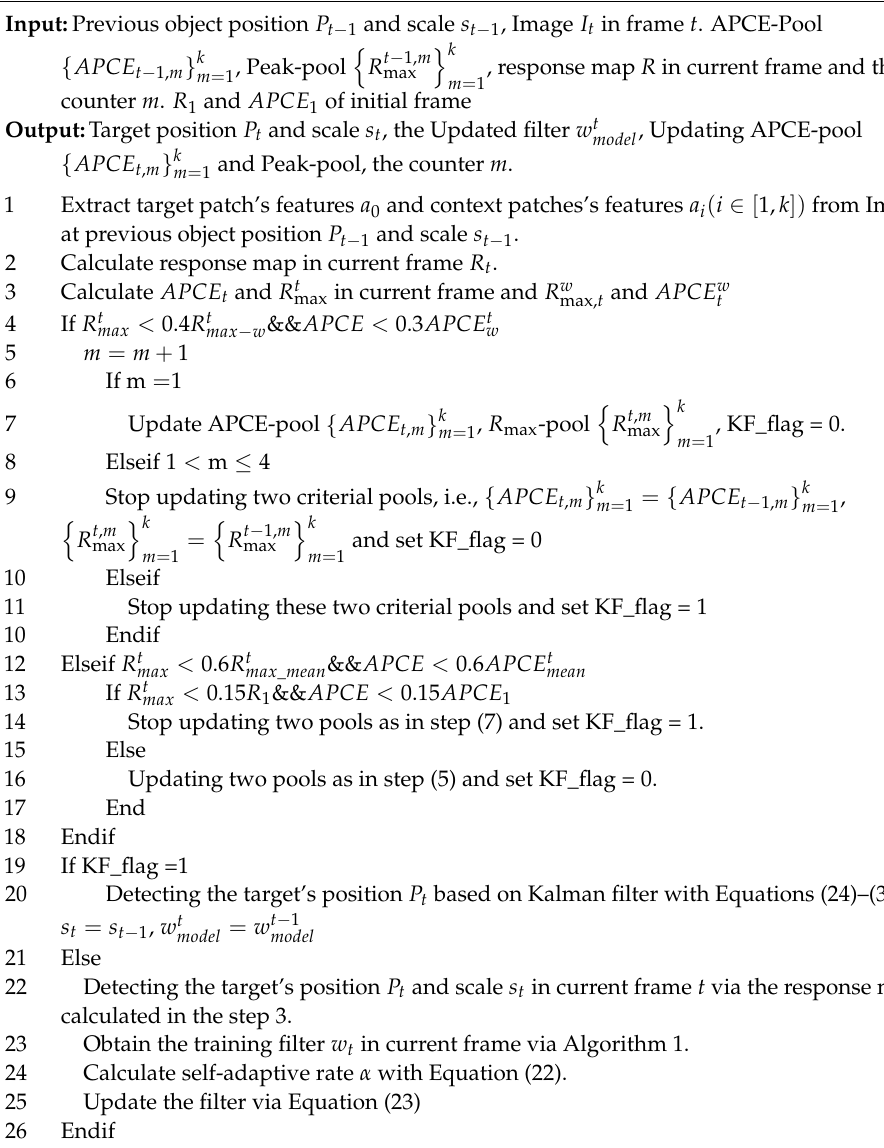
Algorithm 2 Ad_SASTCA tracker at time step t